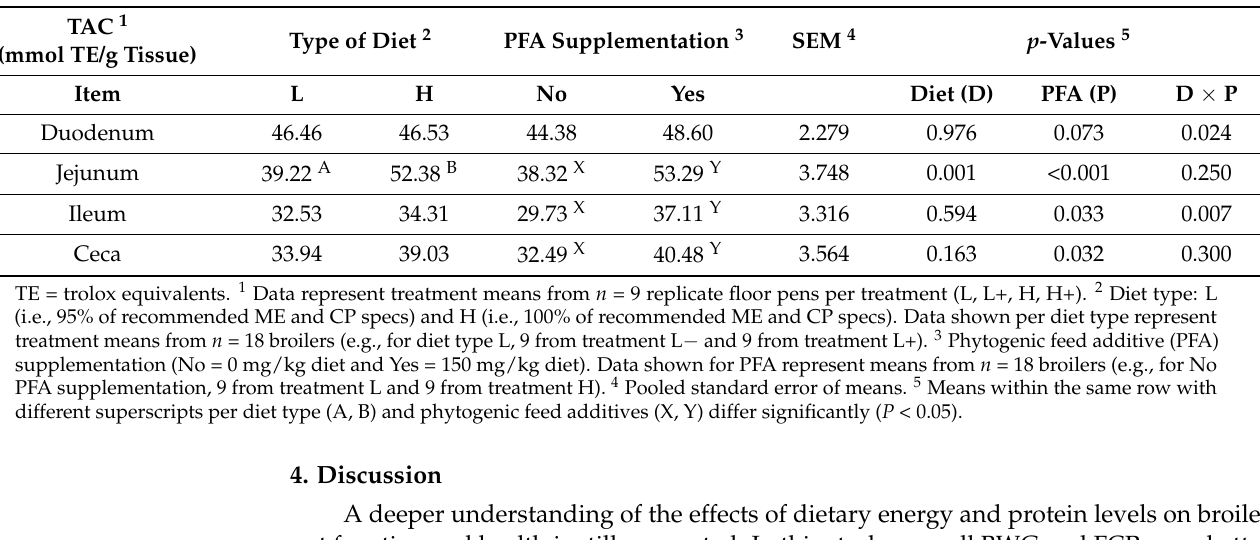
Table 7. Total antioxidant capacity (TAC) along the intestinal mucosa of 42-day-old broilers. TAC 1